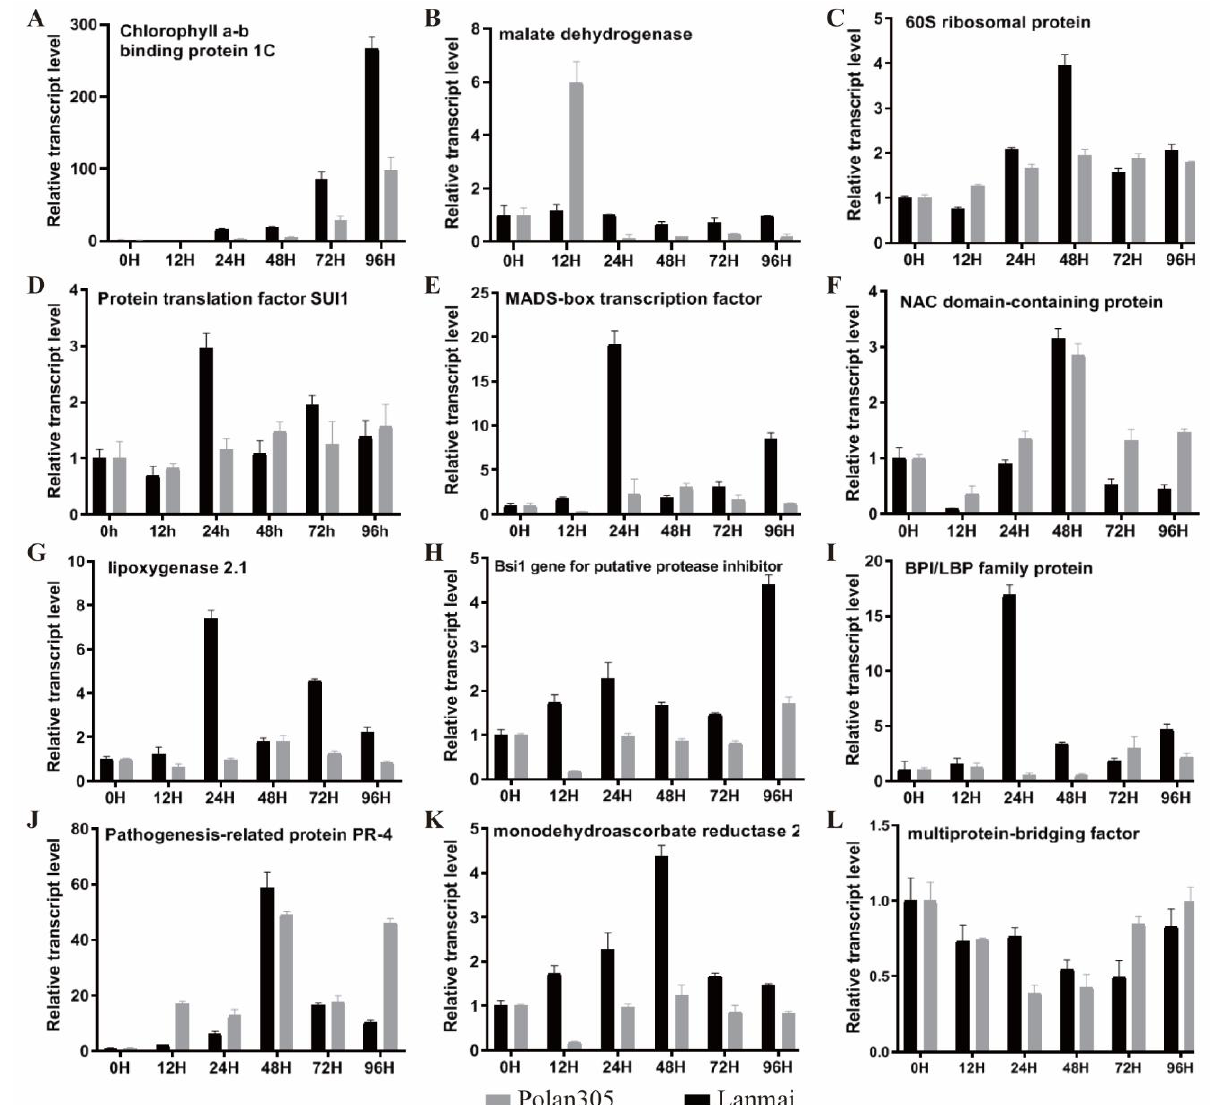
Figure 3. Expression profiles of 12 representative ESTs in seedlings of the resistant (Lanmai) and susceptible (Polan305) varieties under S. avenae infestation at different time points. RT-qPCR was used to detect the expression levels of the candidate genes. TaActin was used as an internal control. Each value represents the mean ± SE of three biological replicates. chlorophyll a-b binding protein ( A ), malate dehydrogenase ( B ), 60S ribosomal protein ( C ), SUI1-like protein ( D ), MADS-box tran-scription factor ( E ), NAC domain-containing protein ( F ), lipoxygenase 2.1 ( G ), Bsi1 gene for puta-tive protease inhibitor ( H ), BPI/LBP family protein ( I ), Pathogenesis-related protein PR-4 ( J ), monodehydroascorbate reductase 2 ( K ), multiprotein-bridging factor ( L